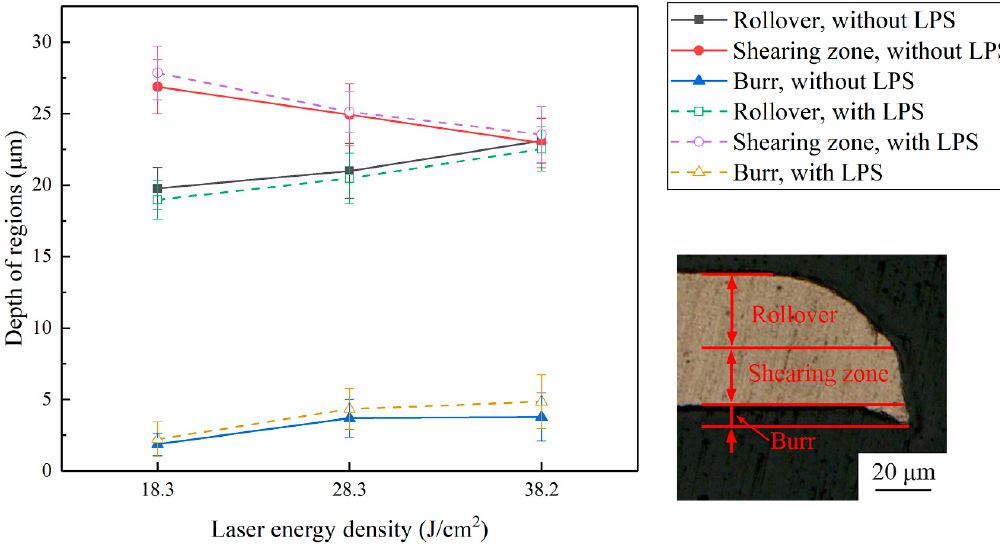
Figure 12. Influence of the laser energy density on the depth of different regions of punched parts with and without LPS.